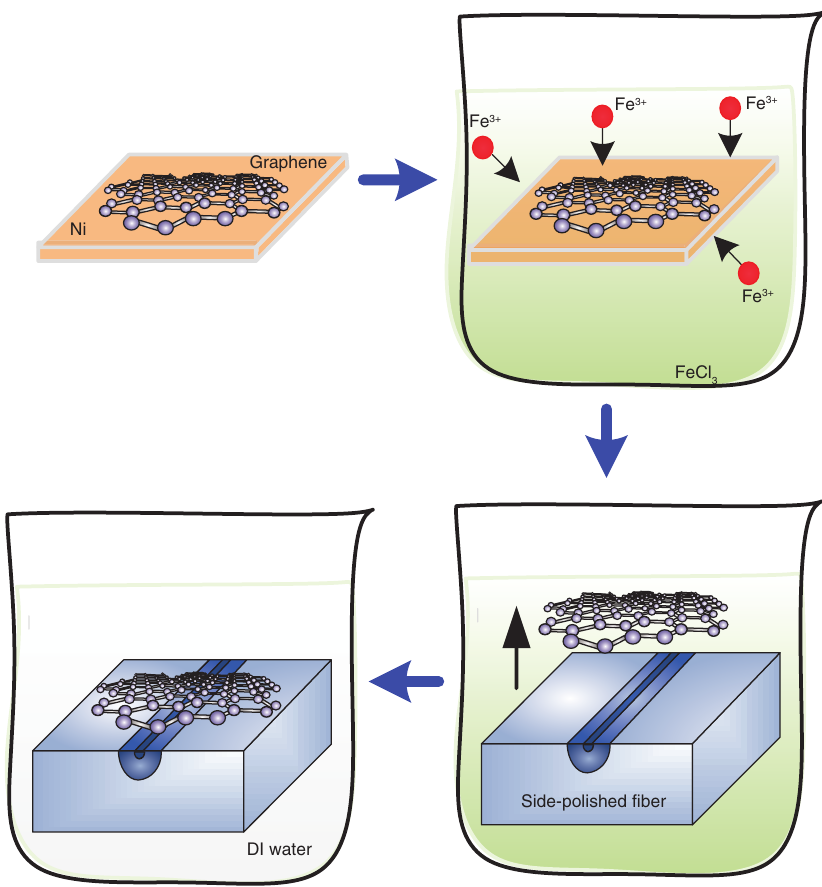
Figure 1: Solution process of few-layer graphene transferred from Ni substrate onto the side-polished